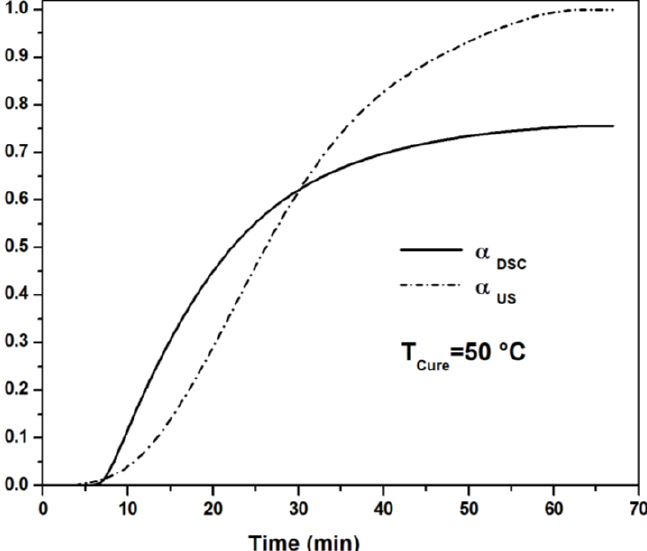
Figure 6. Normalized degree of reaction calculated from DSC and longitudinal modulus (measured at 2 MHz) for an UPE resin during the isothermal cure at 50 °C (adapted from